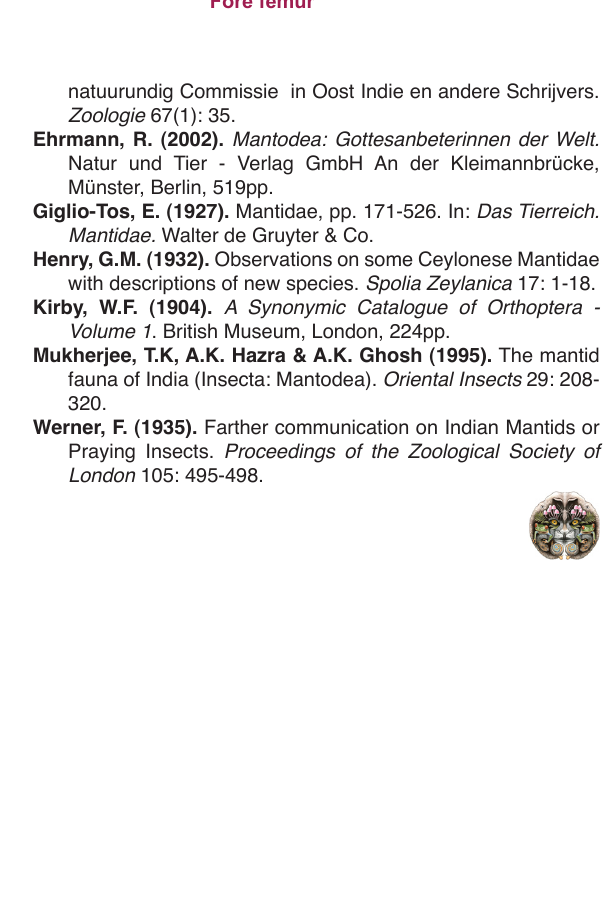
Image 19. Hierodula ventralis Fore